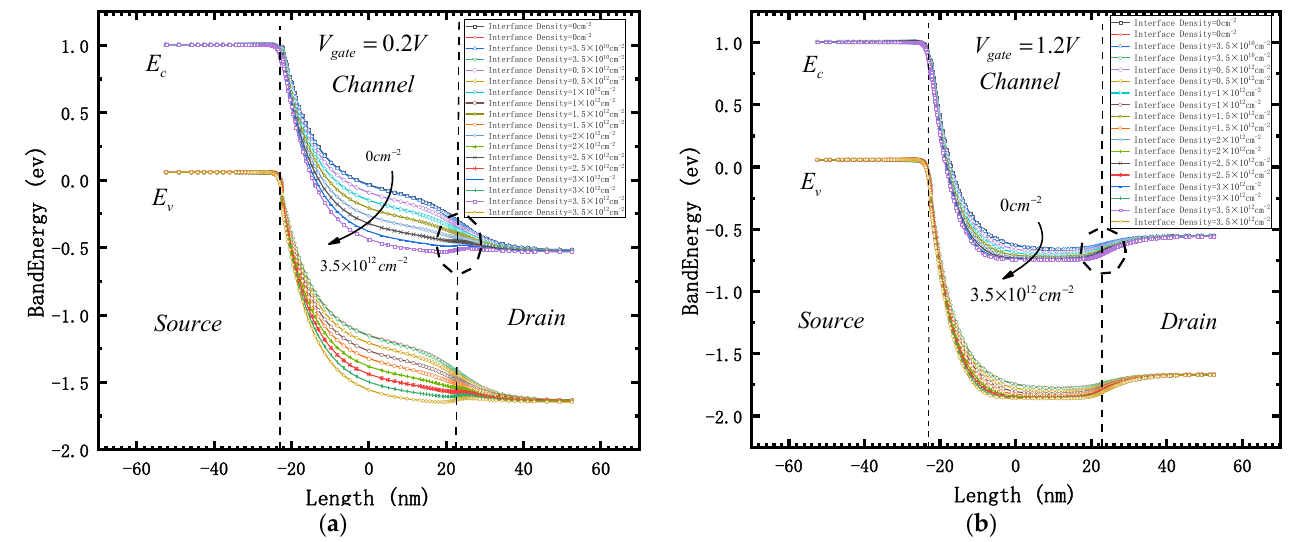
Figure 4. Band diagram with different interface density. ( a ) Gate voltage = 0.2 V; ( b ) gate voltage = 1.2 V.